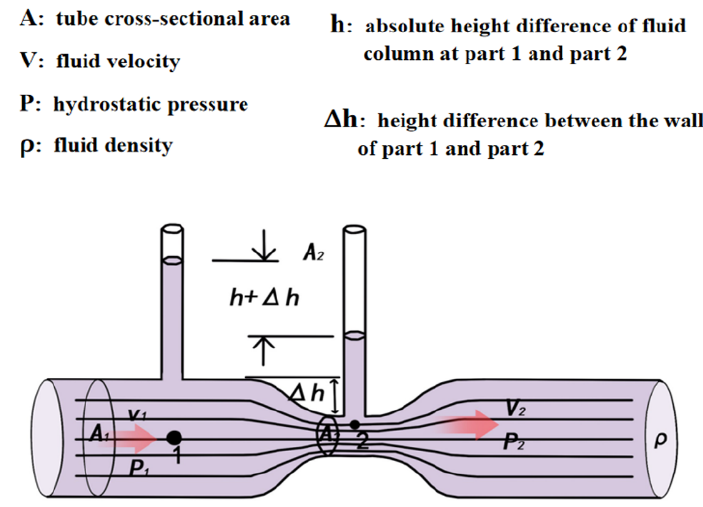
Figure 3. Schematic diagram of a venturi tube.